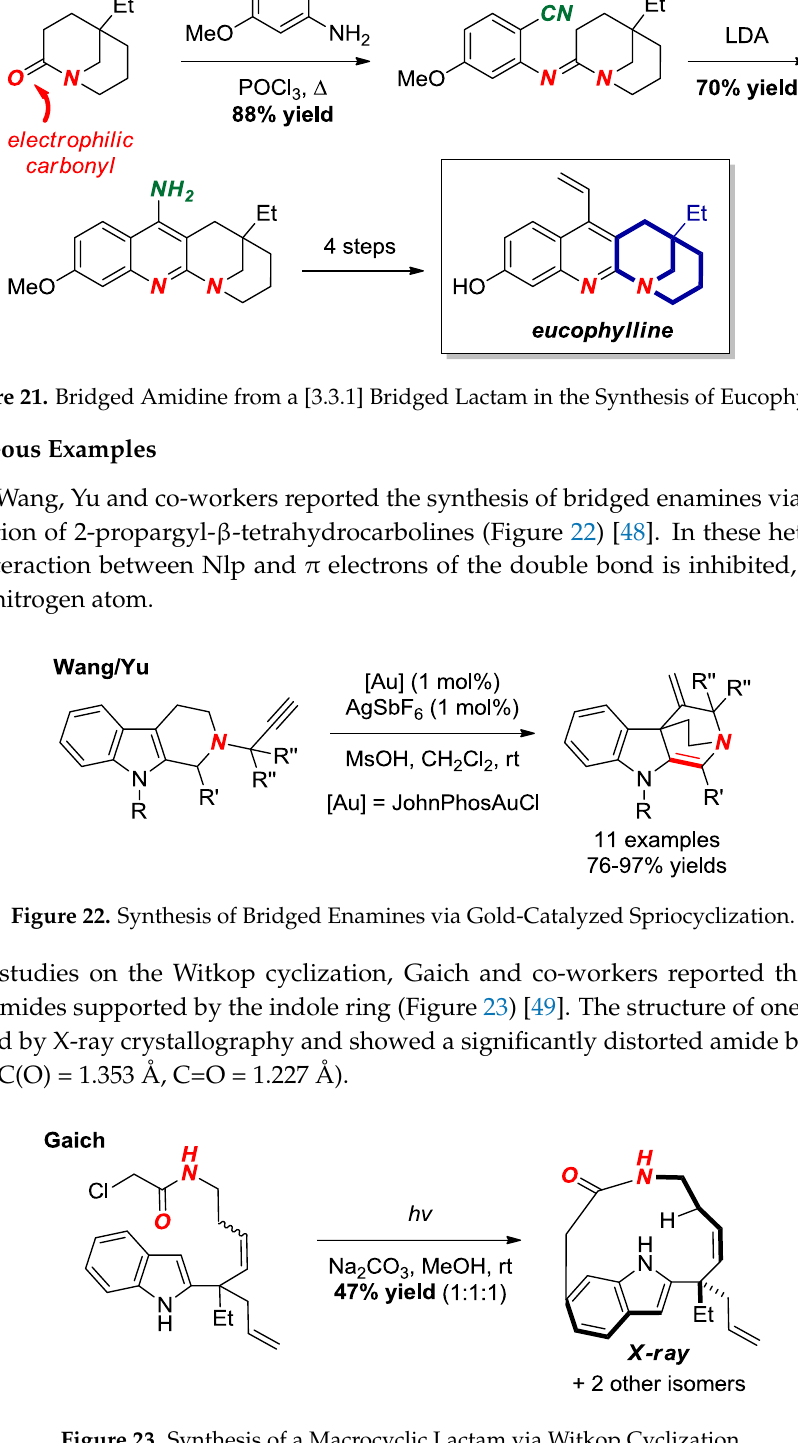
Figure 20. Lactam-to-Lactone Rearrangement of a Bridged Lactam in Haemanthidine Alkaloids.